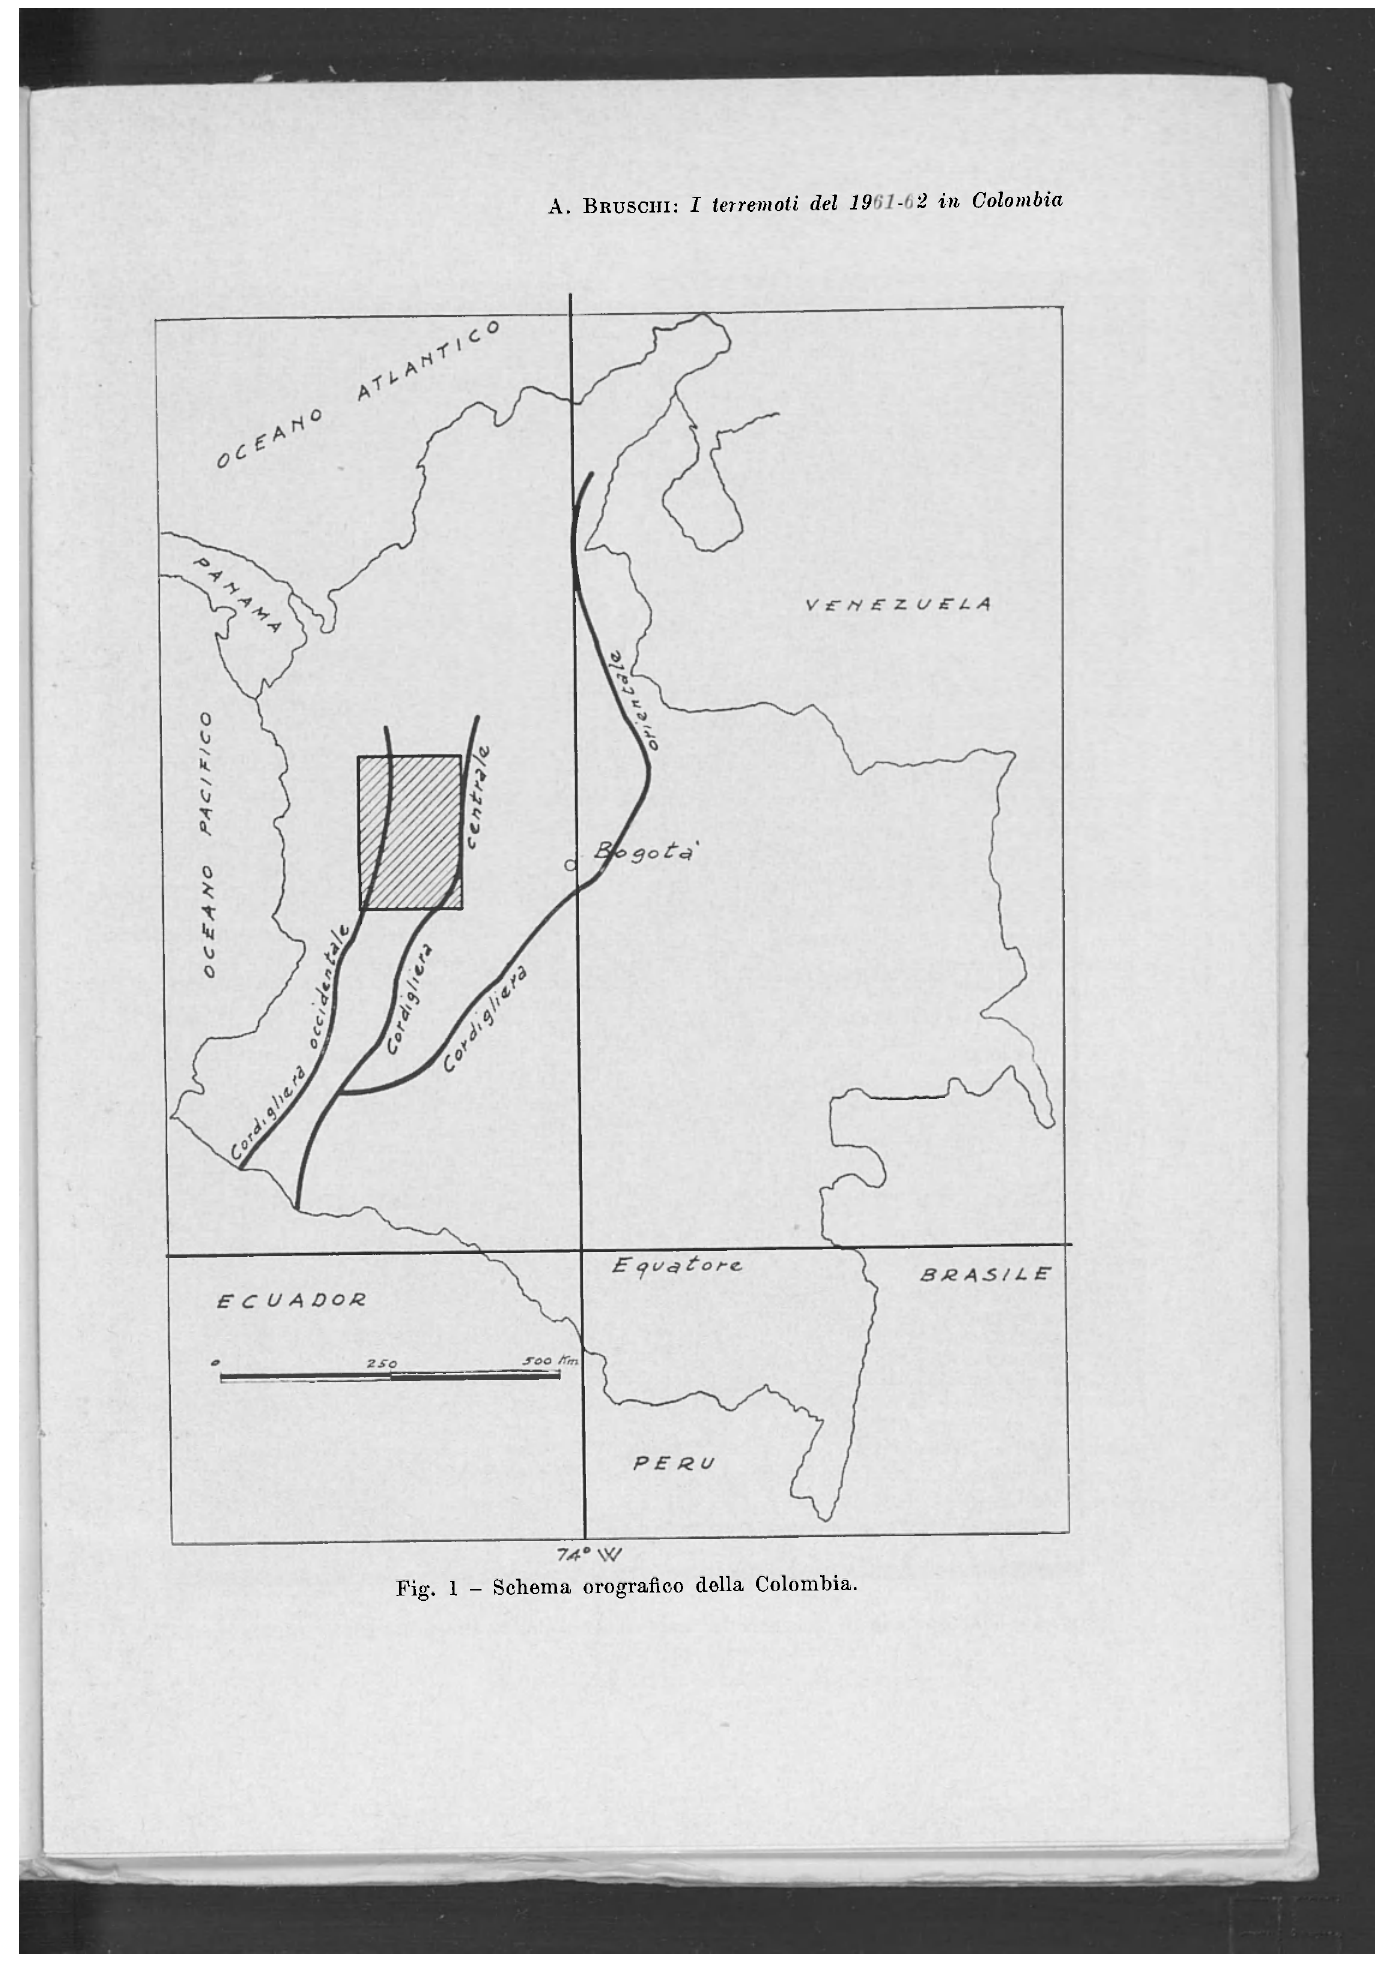
Fig. 1 - Schema orografico della